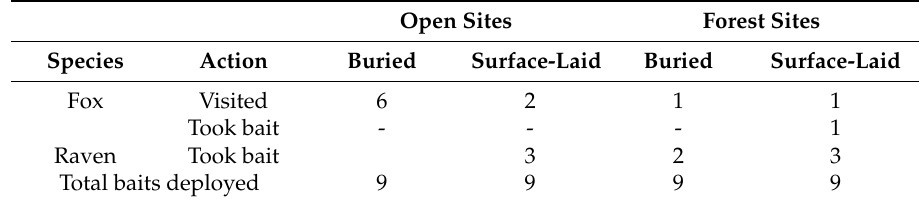
Table 2. Fate of 36 baits placed in open vs. forest sites. Bait stations were monitored over 1 day. Open Sites Forest Sites Species Action Buried Surface-Laid